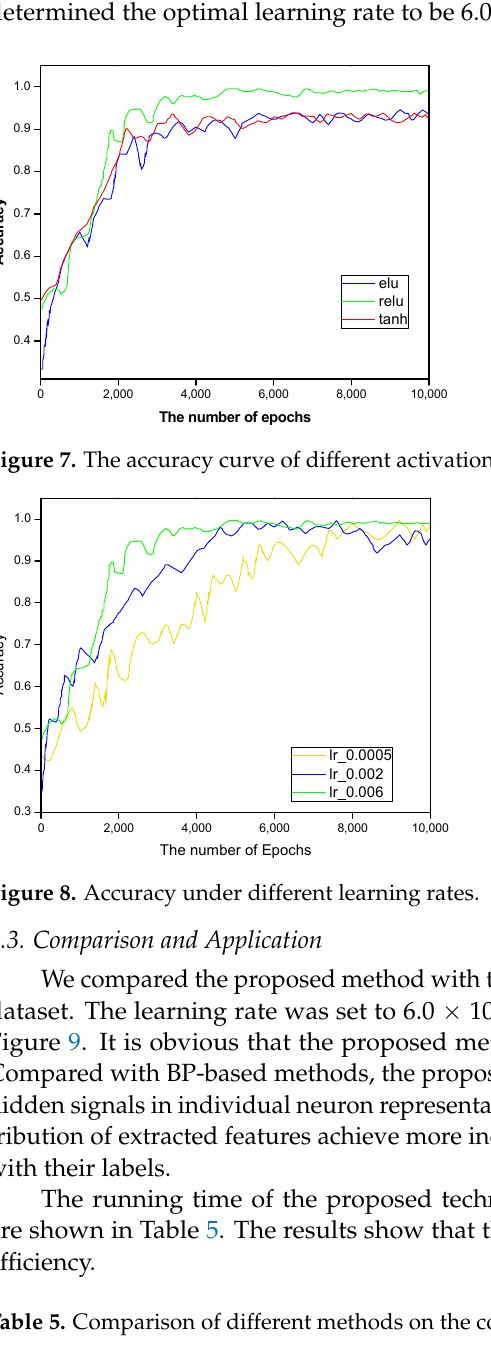
Table 5. Comparison of different methods on the collected